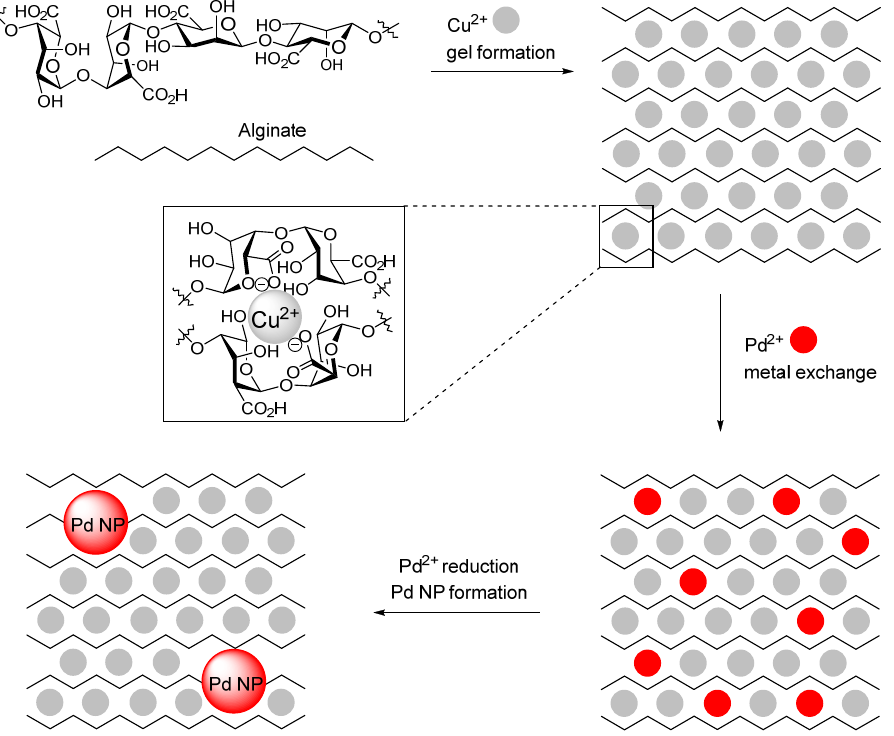
Figure 10. Chemical structure of alginate and schematic presentation of alginate/Cu 2+ /PdNPs preparation [136]. Table 4. Bimetallic nanoparticles in scCO 2 and scH 2 O applied in catalysis. a